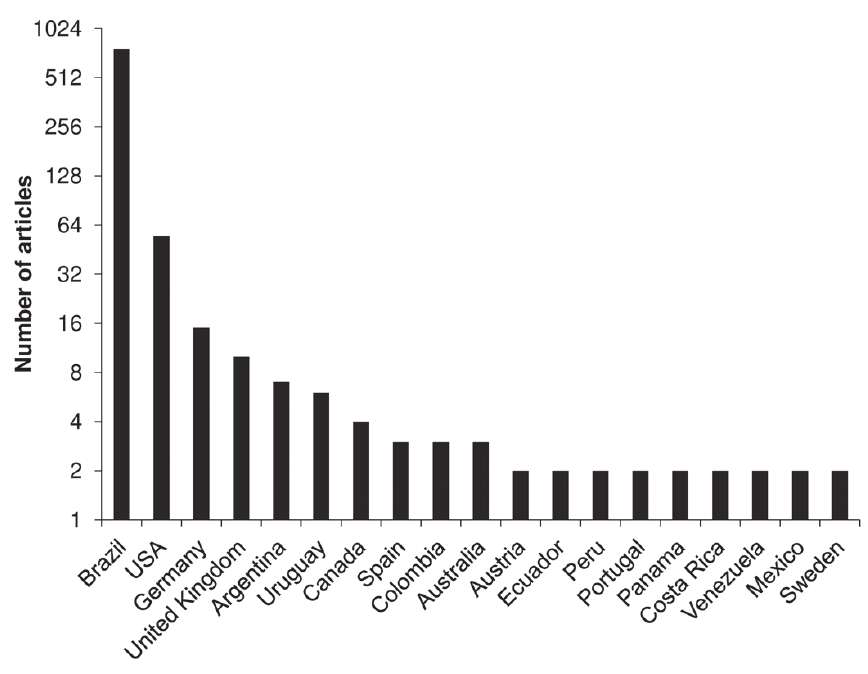
Figure 5 - Total number of articles published between 2001 and 2010 on amphibians from Brazil (N = 892) in relation to the country of affiliation of the